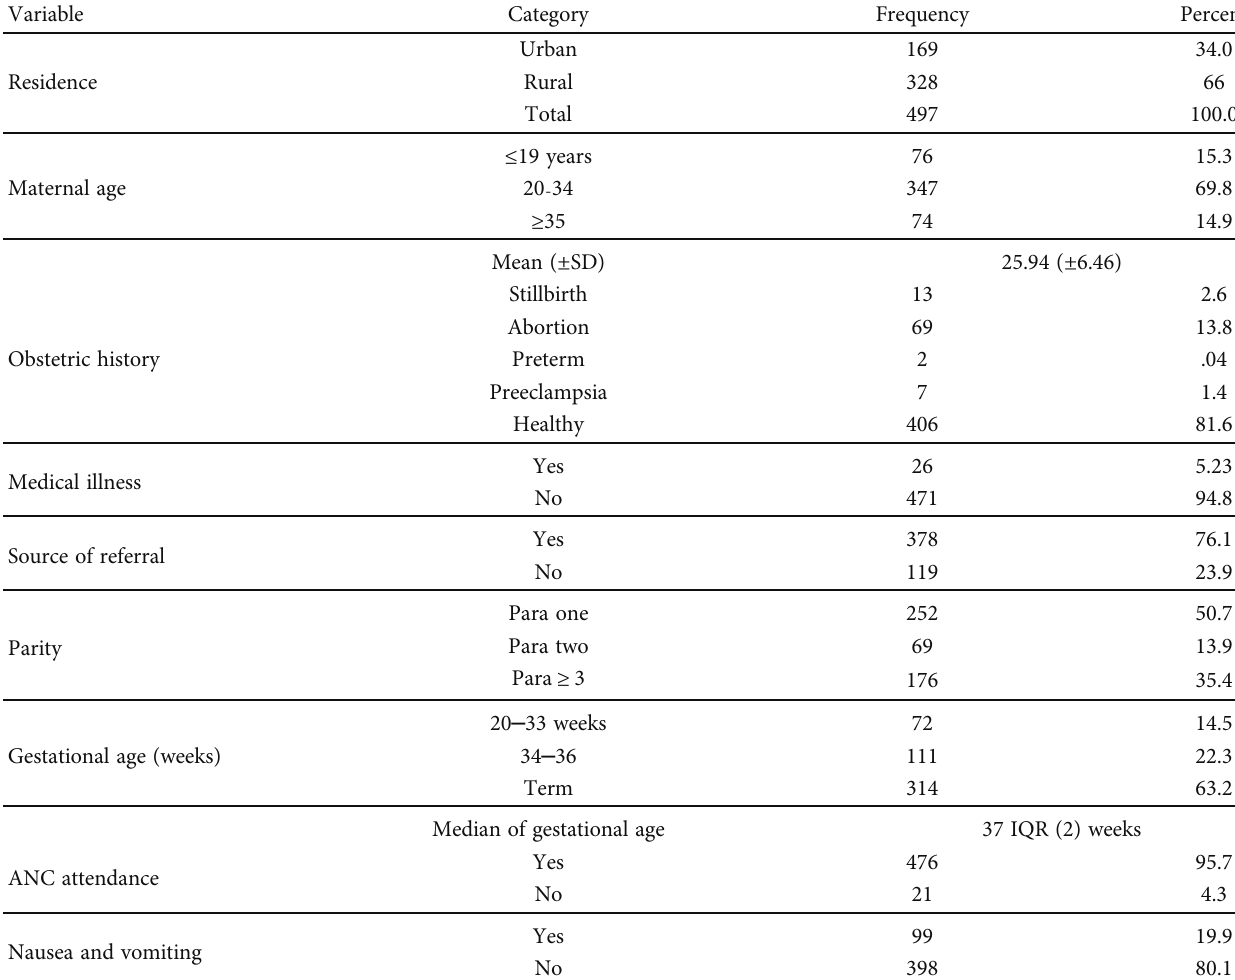
Table 1: Sociodemographic and obstetric characteristics of mothers with hypertensive disorders of pregnancy at Suhul Hospital, Northwest Tigray, Ethiopia, 2019.